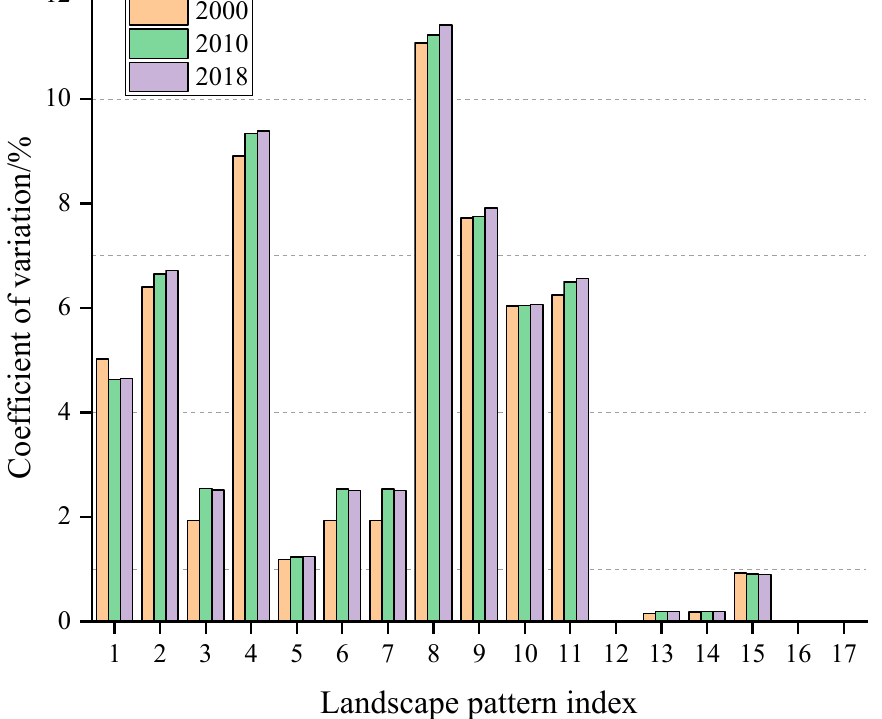
Figure 4. Variation coefficient of the landscape pattern index in response to spatial granularity. Note: 1–17 represent LPI, ED, AREA_MN, SHAPE_MN, FRAC_MN, NP, PD, SPLIT, CONTAG, AI, LSI, TA, IJI, COHESION, DIVISION, SHDI, and SHEI,